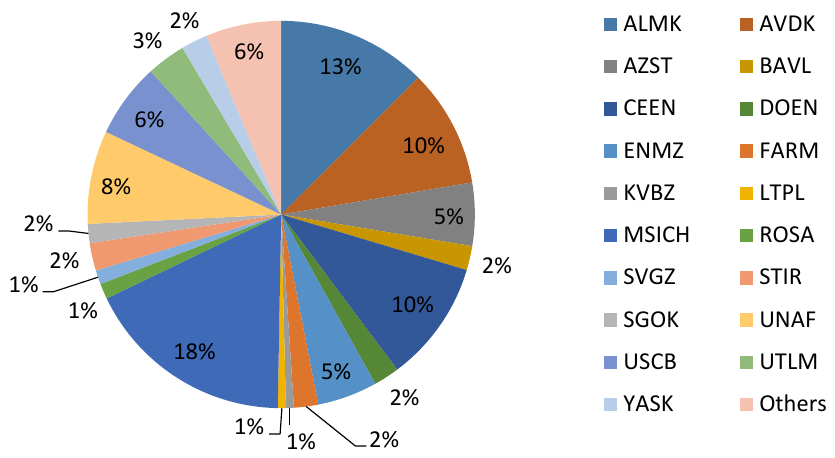
Figure 2. Structure of trades in the Ukrainian Stock Exchange: case of issuers in